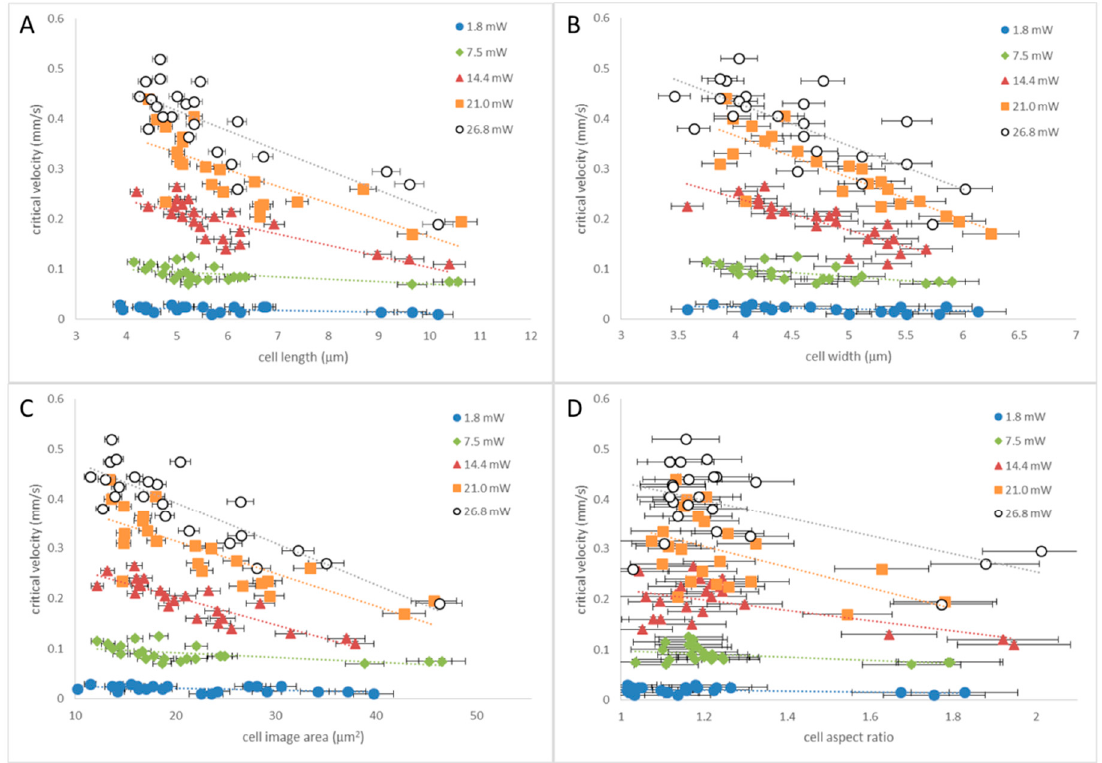
Figure 6. Critical velocities, v c plotted against yeast cell dimensions. ( A ) Critical velocity ( v c ) vs. cell length ( b ); ( B ) v c vs. cell width ( a ); ( C ) v c vs. cell area; ( D ) v c vs. aspect ratio ( b/a ). Lines act as a guide to the eye.